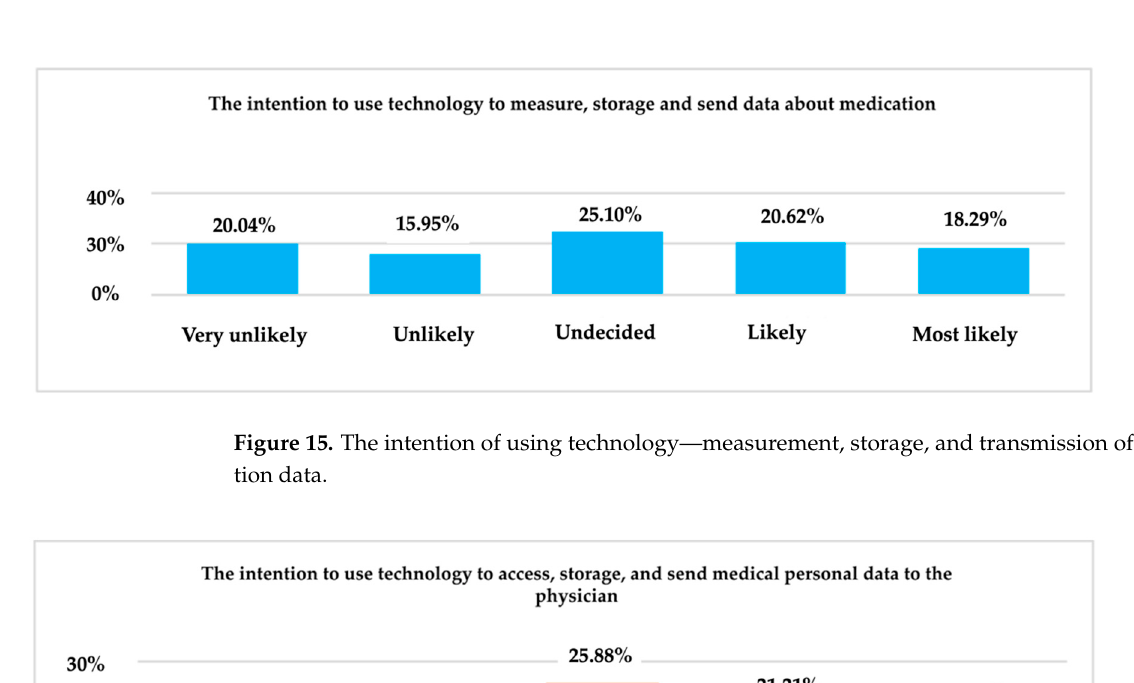
Table 3. The importance of technology tool features.